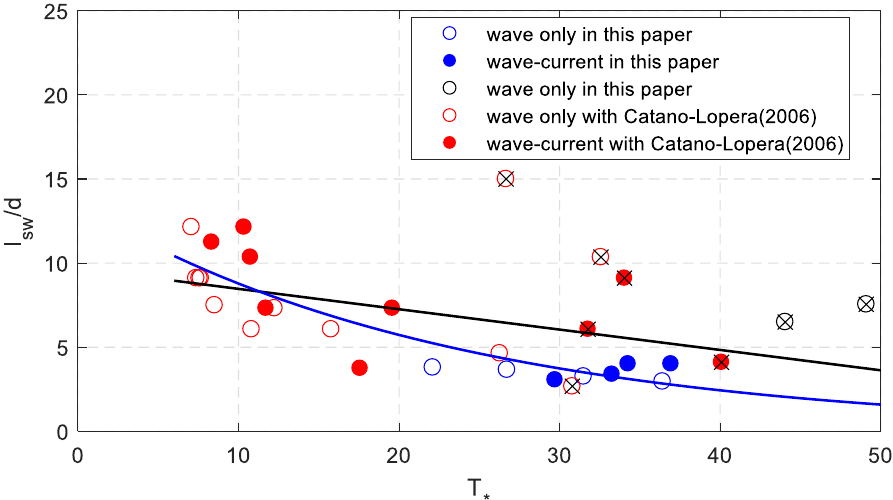
Figure 8. The relationship between the measured dimensionless sand wave length and dimensionless shear